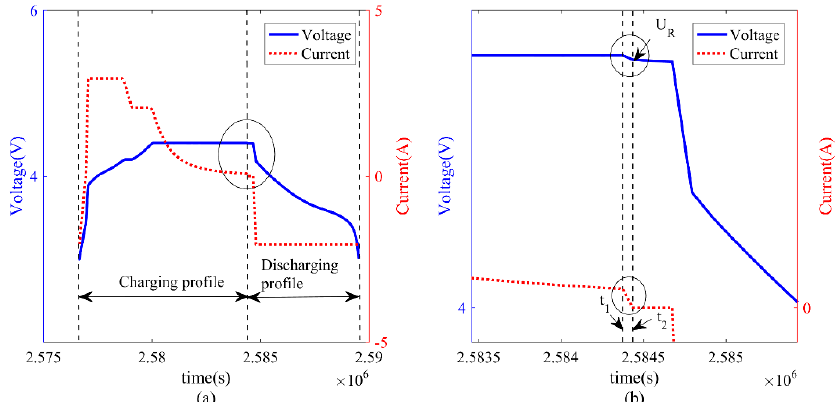
Figure 6. Discharge profile to calculate the EIR; ( a ): voltage and current curves of a full cycle; ( b ): partial magnification of ( a ).